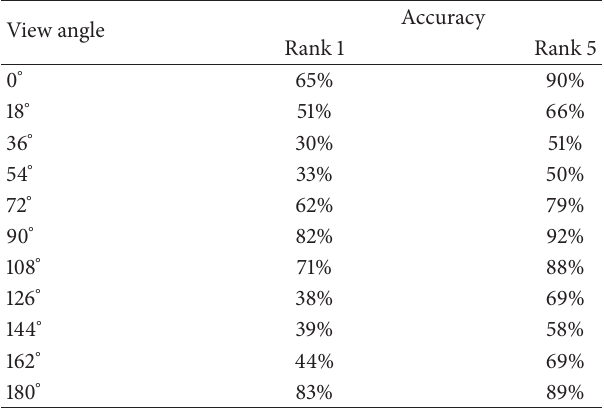
Table 1: Comparison of identification performance under different view